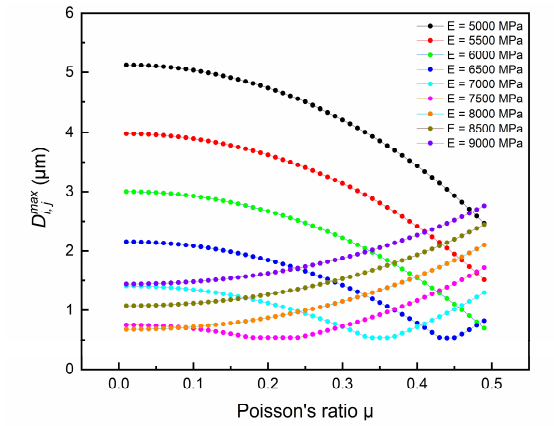
Figure 7. The maximum simulated deviation D max by using different 𝐸 and 𝜇 .